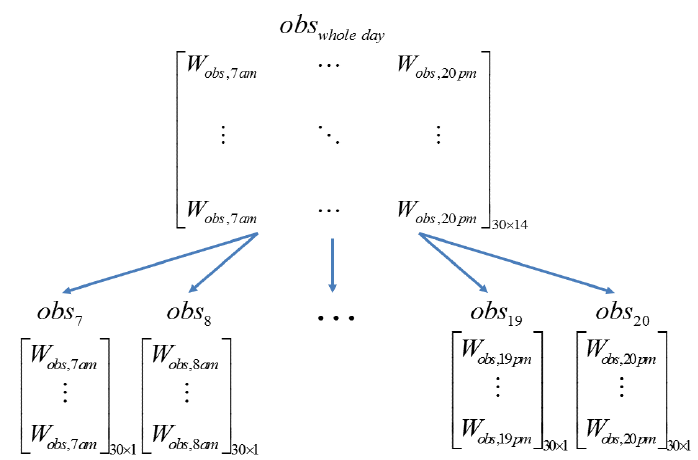
Figure 3. The fourteen-hour observation training sets obtained from the inclusion of the daylight data only (step 1).